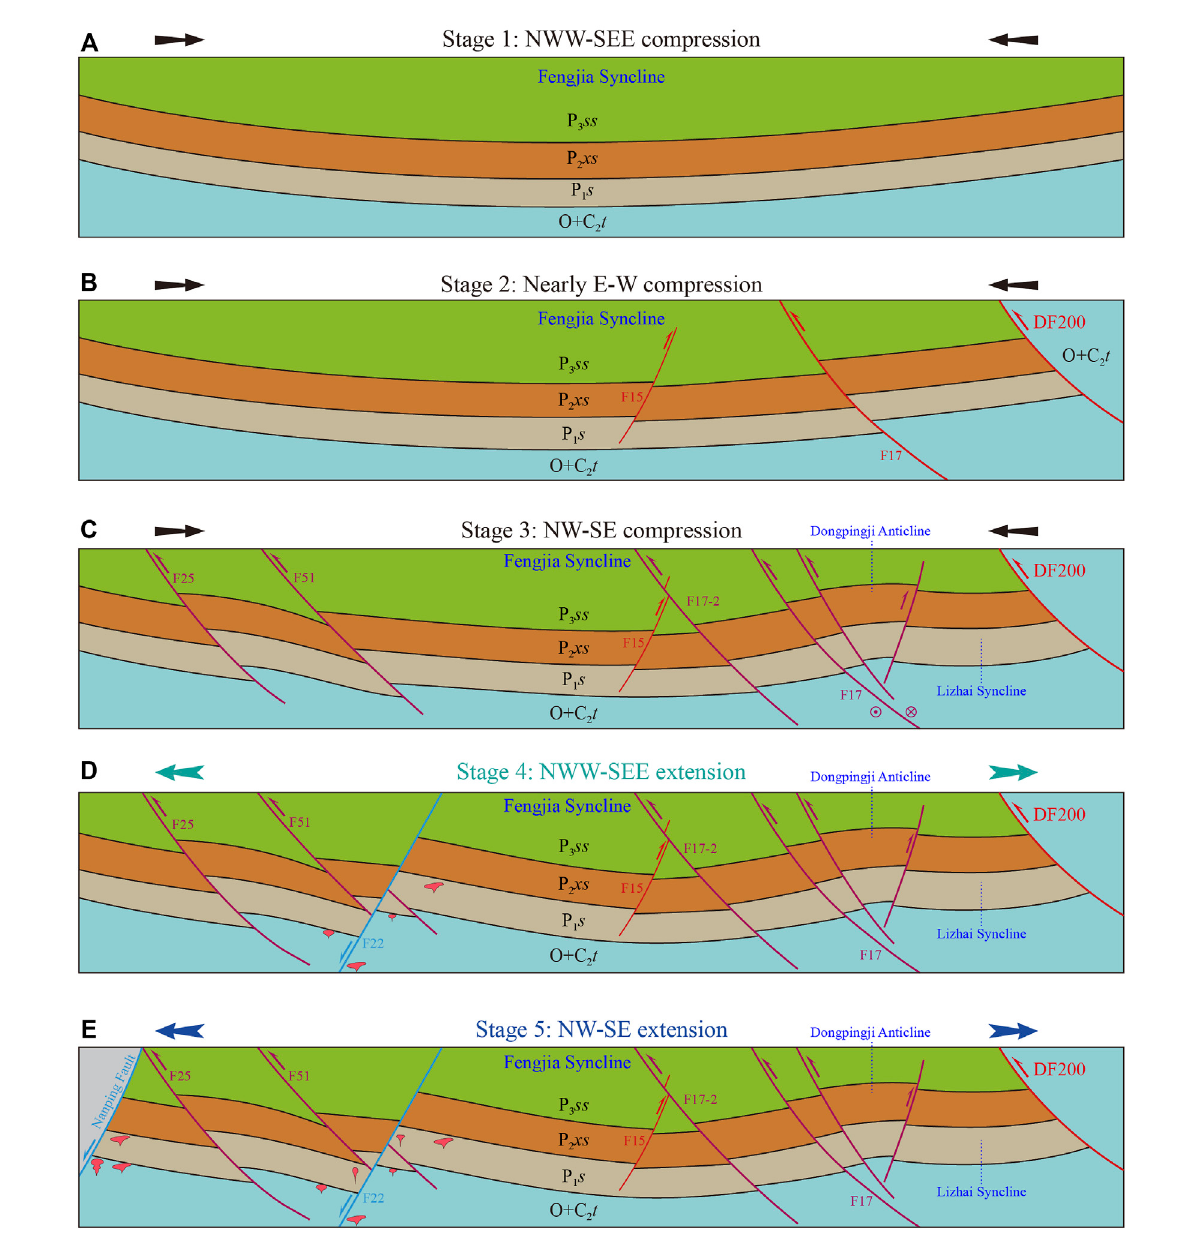
FIGURE 4 Schematic diagrams of the development history of major folds and faults in the Qianyingzi Coal Mine. (A) ItdevelopedtheFengjiaSynclinewitha NNE-trending axis under NWW ‒ SEE compressive stress in the fi rst stage. (B) It developed a series of nearly N ‒ S-striking reverse faults under nearly E ‒ W compressivestressinthesecondstage. (C) TheNNE-strikingreversesinistralfaultsandNE-strikingreversefaultsdevelopedunderNW ‒ SEcompressivestress in the third stage. (D) The nearly N ‒ S-striking normal faults were developed under nearly E ‒ W extensional stress in the fourth stage. (E) The NE ‒ SW- striking normal faults were developed under NW ‒ SE extensional stress in the fi fth